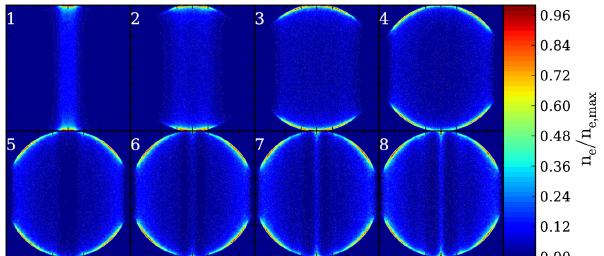
FIG. 6. Snapshot of electron cloud profiles 6 × σ bunch peak in the presence of external dipole magnetic field for 2 . 5 × 10 10 , 5 × 10 10 , 1 × 10 11 , 2 × 10 11 , 3 × 10 11 , 4 × 10 11 , 5 × 10 11 , and 6 × 10 11 bunch populations in round LHC like ¼ 1 . 4 pipe. δ max